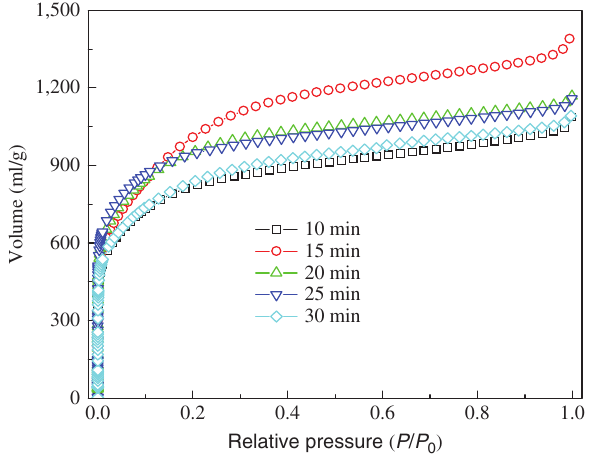
Figure 5: Nitrogen adsorption isotherm of the activated carbon with different microwave heating